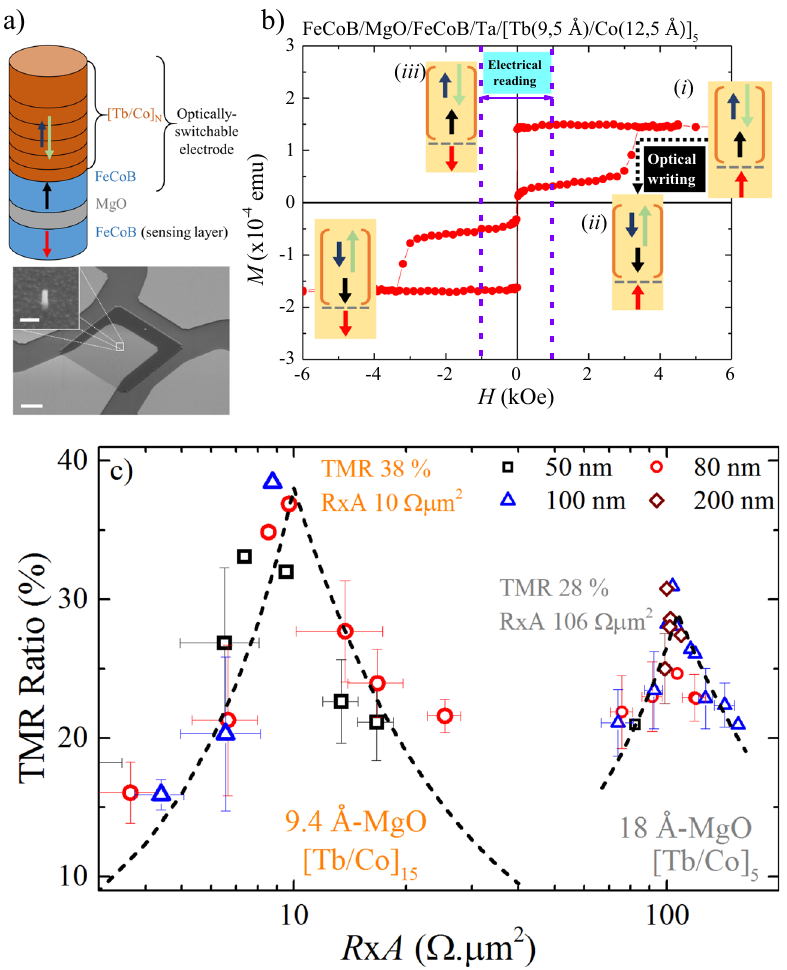
Figure 4. ( a ) Top: Schematic of the MTJ studied. The MTJ consists of an optically-switchable storage layer CoFeB (13 Å )/Ta/[Tb/Co] N and a CoFeB free layer, separated by a MgO tunnel barrier. Bottom: SEM Image of the 50 nm patterned MTJ in an intermediate step of the nanofabrication process. (scale bar: 4 μ m). Inset: Zoom of the capping layer of the 50 nm-junction before the deposition of the upper electrical contact (scale bar: 100 nm) ( b ) Out-of-plane M ( H ) curve measured for the MTJ with the stack [Tb/Co] 5 . Insets: illustrations of the 4 magnetic states of the MTJ indicating the stages intended for optical writing (state ( i ) to state ( ii )) and electrical readout (state ( i ) to state ( iii )). ( c ) TMR vs RxA of nano-patterned junctions for stacks with different repetition numbers N of the [Tb/Co] N stacks as indicated, with 9.4 Å and 18 Å MgO barriers. The dispersion in the TMR and RxA as calculated from shunt and series resistance models (dashed lines) are also shown. The wafer-level TMR potential for optimal processing is 38% and 28%